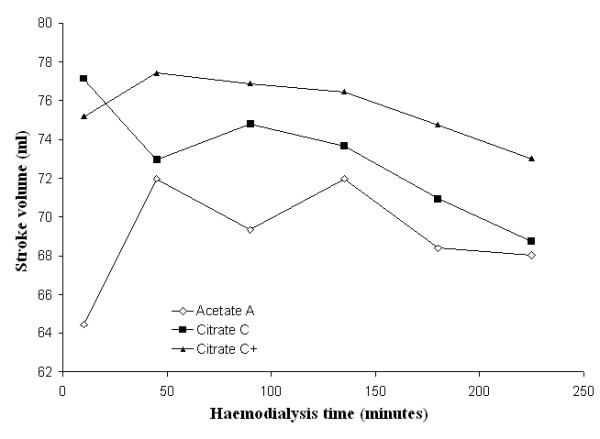
Stroke volume. Stroke volume as a function of the haemodialysis time using, respectively, acetate (A) (empty diamonds), calcium uncorrected citrate (C) (black squares) and calcium supplemented citrate dialysate (C+) (black triangles).